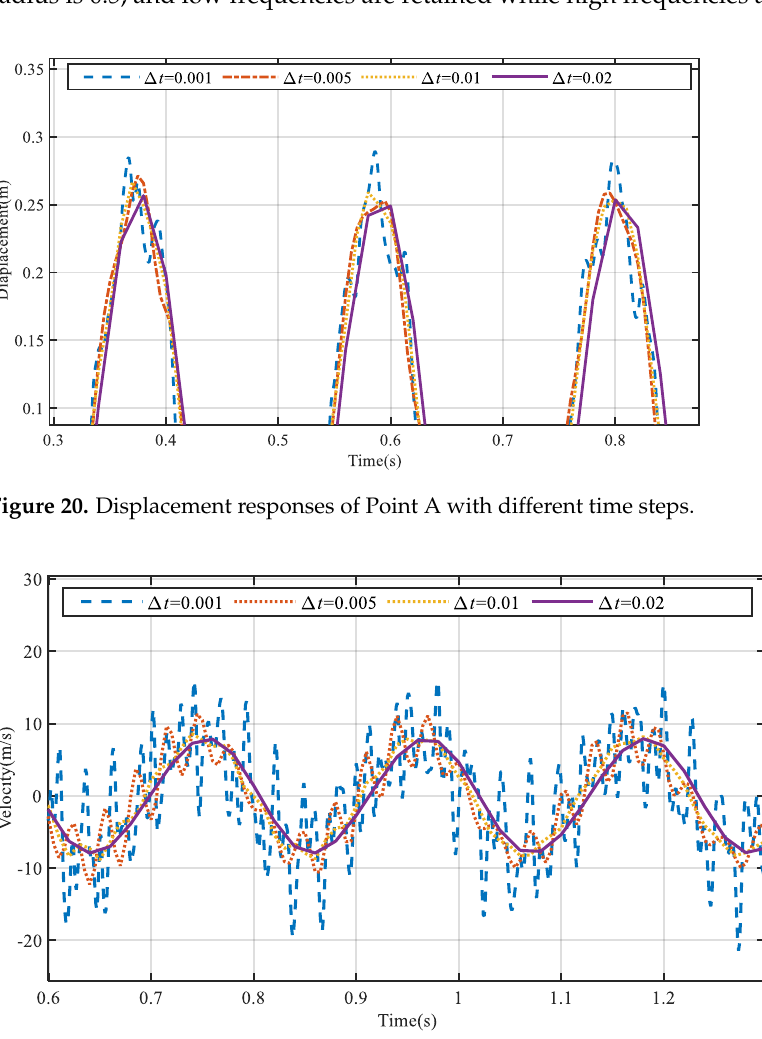
from 0 to 1.5 s; ( b ) partial enlarged drawing of responses.